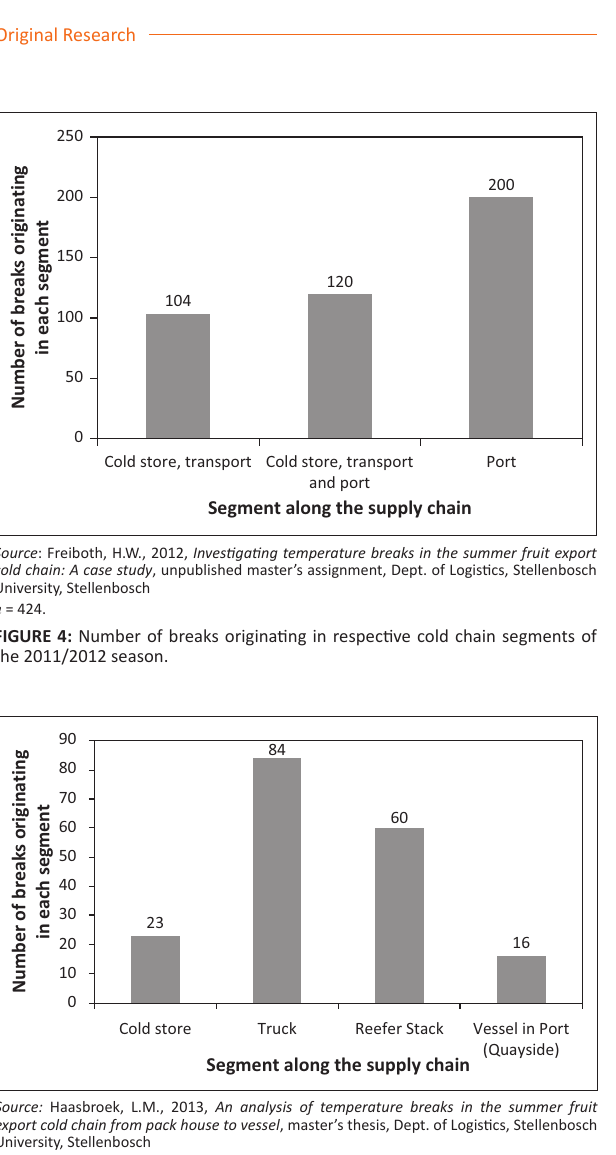
FIGURE 5: Number of breaks originating in respective cold chain segments of the 2012/2013